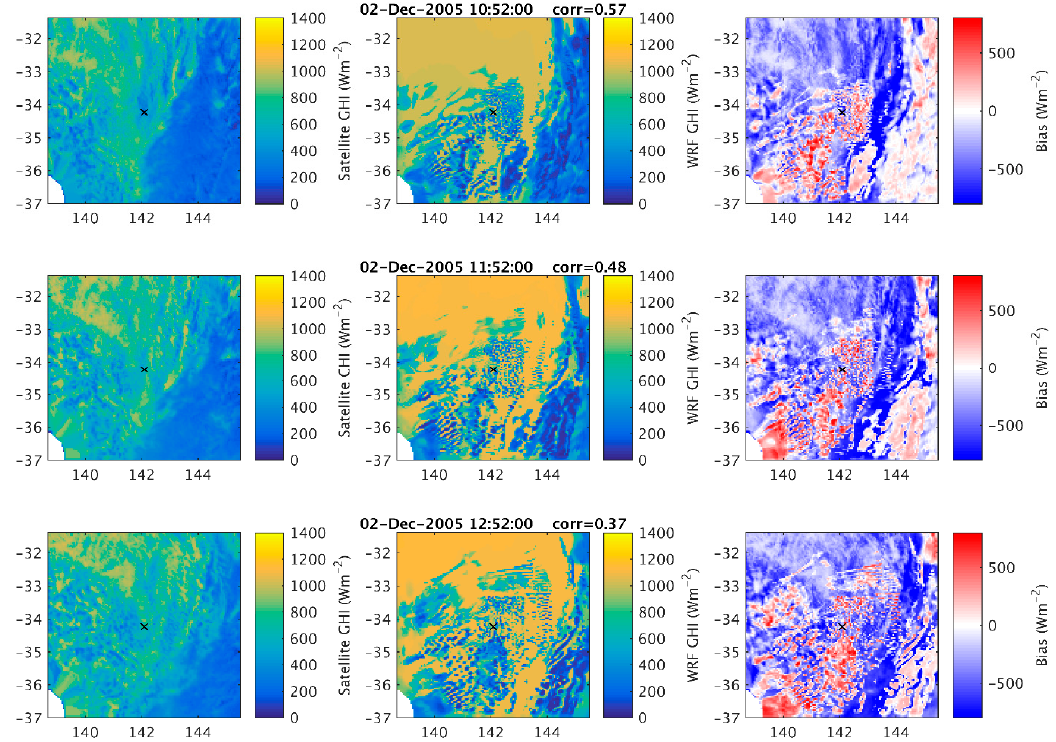
Figure 8. Spatial distribution of GHI observed from the satellite (left), simulated by WRF-Solar (centre) and the bias (right) for intermittent case on 2 December at three satellite overpassing times (top to bottom).